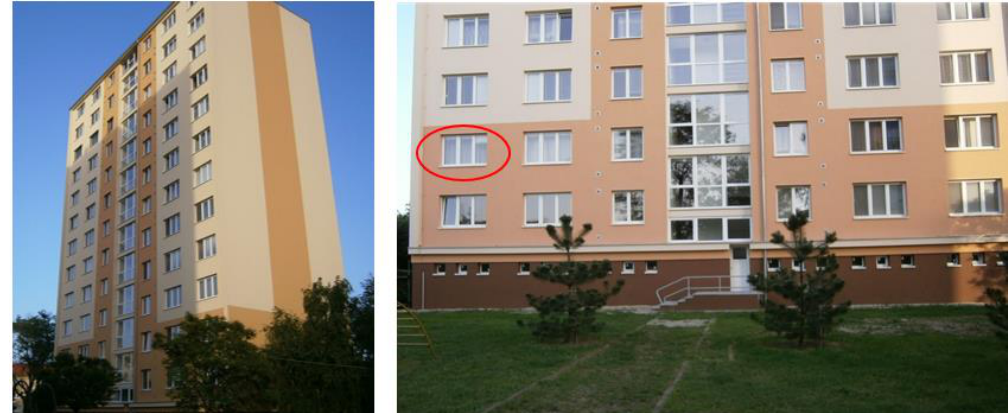
Figure 3. External view of selected apartment building, (source authors).